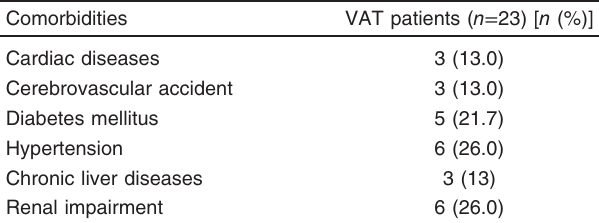
Table 3 Comorbidities of ventilator-associated tracheobronchitis